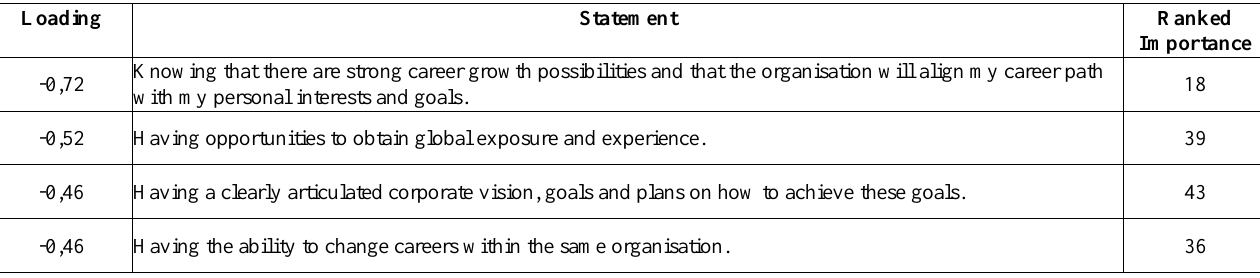
Table 6: Variables associated with factor four